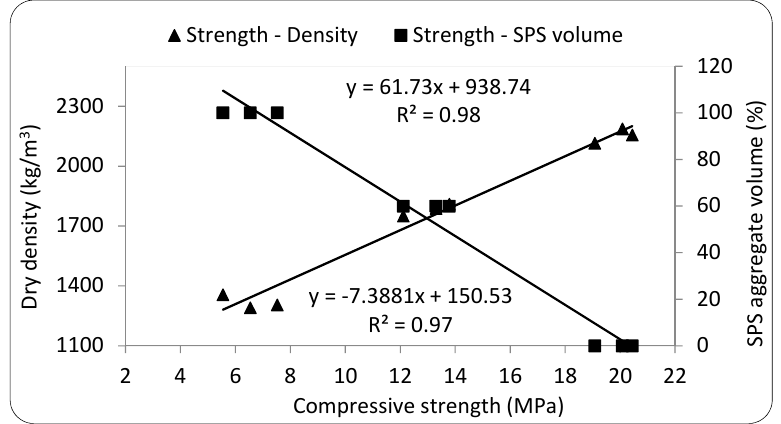
Figure 11. Correlation between strength, density, and SPS volume.